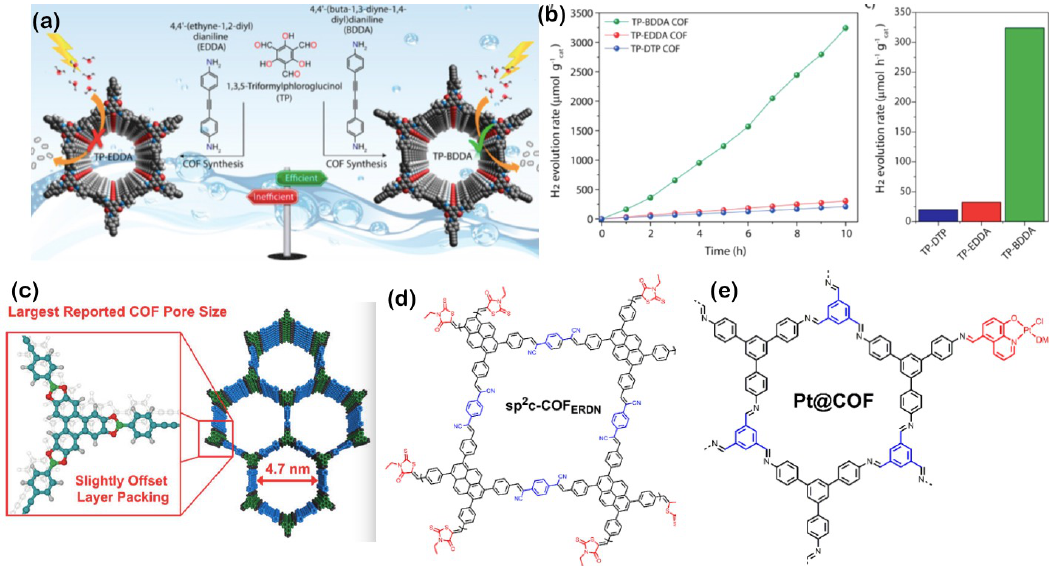
Figure 20. ( a ) Synthesis and characterization of TP-EDDA and TP-BDDA covalent organic frameworks (COFs) and ( b ) the comparison of hydrogen evolution performance and rate of TP-BDDA, TP-EDDA and TP-DTP catalysts under sunlight irradiation using TEOA as a sacrificial agent. Reproduced with permission from reference [269]. Copyright 2018, American Chemical Society. ( c ) Synthesis of HHTP-DPB COF in Model of the Idealized bnn Topology (right) and expansion of the region (left). Reproduced with permission from reference [267]. Copyright 2019, Elsevier. Structures of ( d ) sp 2 c-COF ERDN and ( e ) Pt@COF (truncated monomer and the corresponding multitopic monomer are in red and blue, respectively. Reproduced with permission from reference [270,271]. Copyright 2020, Elsevier and 2012, Royal Society of